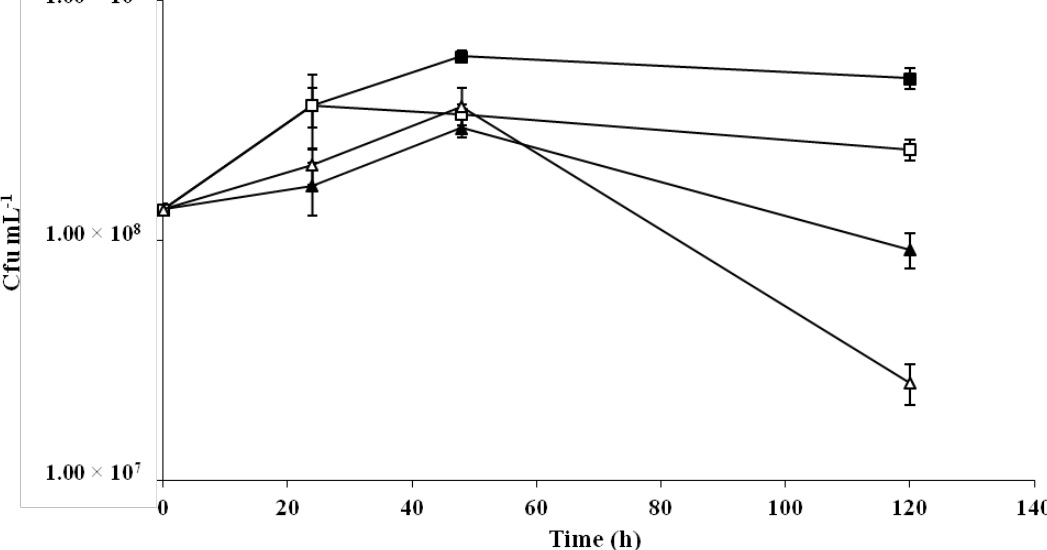
Figure 2. Analysis of prebiotic potential of the O 2-substituted (1,3)-β- D -glucan. The viability of Lactobacillus plantarum WCFS1 was monitored over a 5-day period in oat (square) and rice (triangle) food matrices, previously fermented for 40 h by P. parvulus 2.6 (black symbols) or 2.6NR (white symbols) strains. Table 3. O 2-substituted (1,3)-β- D -glucan (mg·L −1 ) production in oat and rice products fermented 40 h by P. parvulus 2.6 submitted to a thermal treatment, and subsequently inoculated with L. plantarum WCFS1 (time 0) and after 5 days incubation at 37 °C. Three independent experiments were performed in duplicate. Time (h) Oat Rice